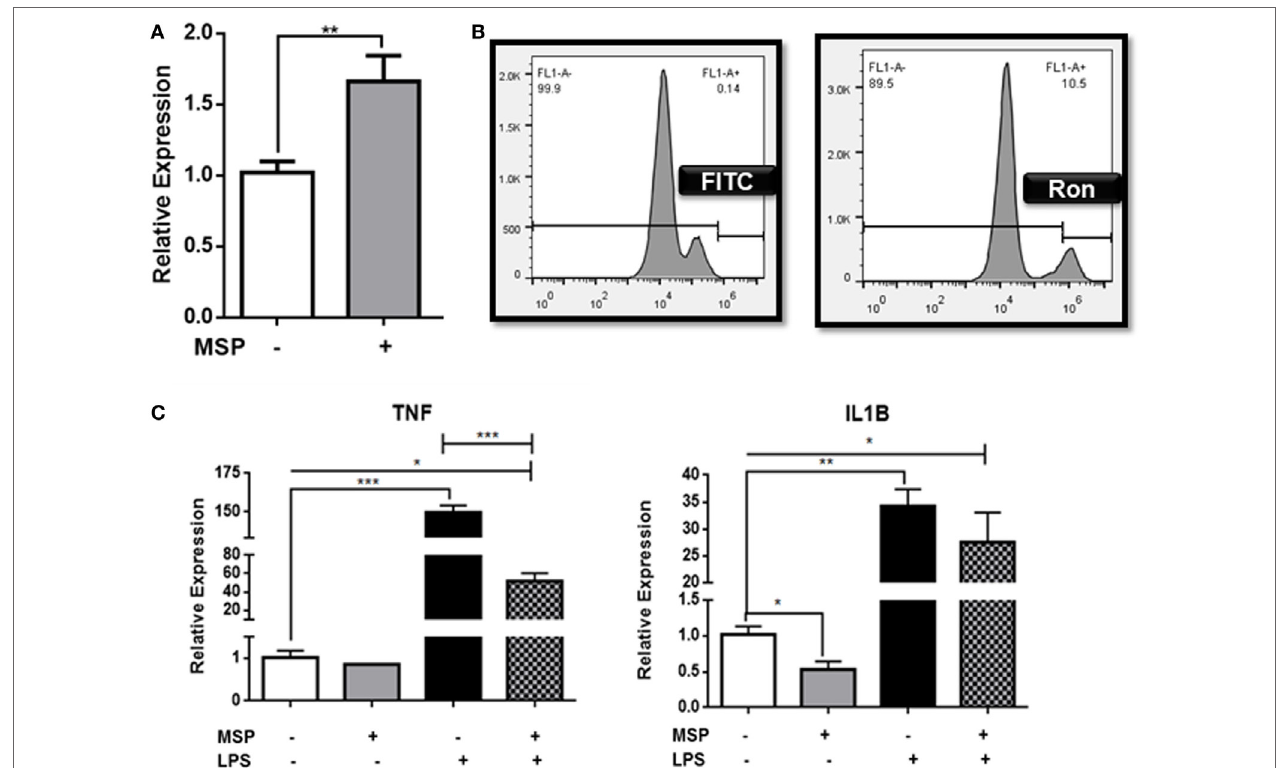
FigUre 1 | Ron suppresses lipopolysaccharide (LPS)-induced upregulation of TNF α in CHME-3 cells. (a) CHME-3 cells were cultured in the presence or absence of macrophage-stimulating protein (MSP) and expression of Ron was assessed by qPCR. (B) Cell surface expression of Ron on CHME-3 cells. (c) CHME-3 cells were stimulated for 4 h with LPS in the presence or absence of MSP. TNF α and IL-1B expression was assessed by qPCR. Data are representative of three individual experiments (* P < 0.05, ** P < 0.01, *** P <